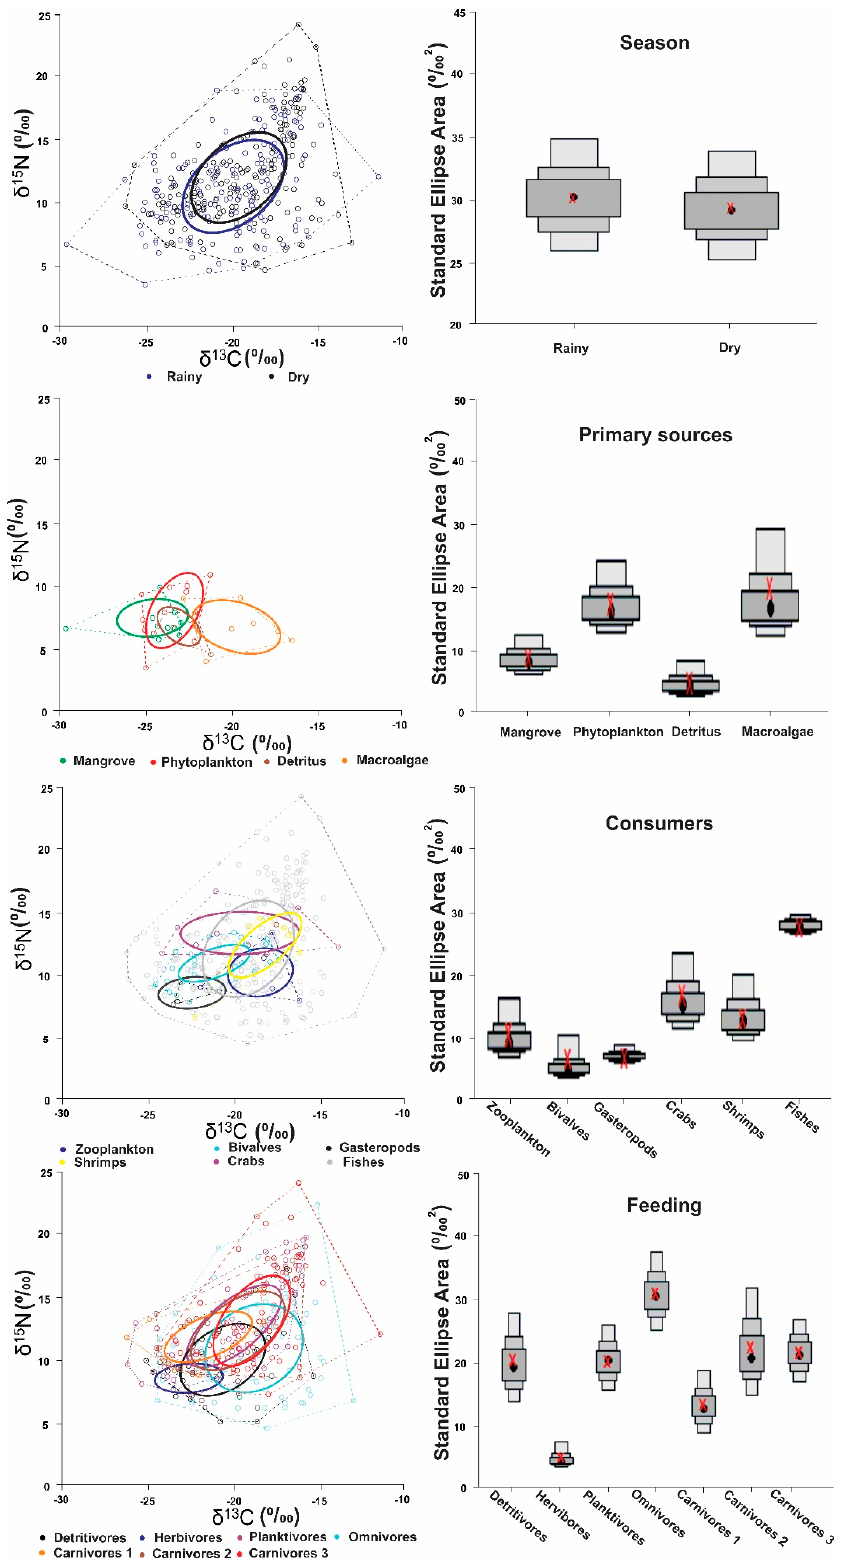
Figure 4. Comparison of the area of the isotopic niches by groups: Between season for all species, primary sources, consumers (taxonomic group), and feeding guild. Rectangles represent the 50, 75, and 95% credible intervals (dark to light shading, respectively), and black dots represent the mode values.